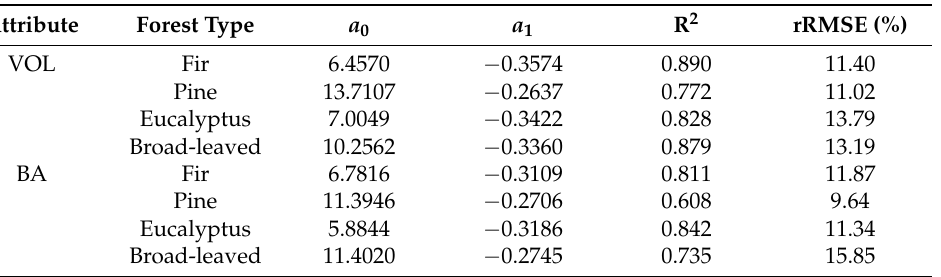
Table 5. Parameter estimates of the multiplicative power regression models for the relationship between rRMSE (%) and plot size (ha) and their goodness-of-fit statistics.